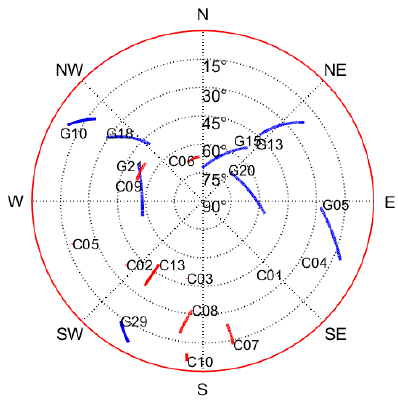
Figure 6. Satellites visibility in the test.